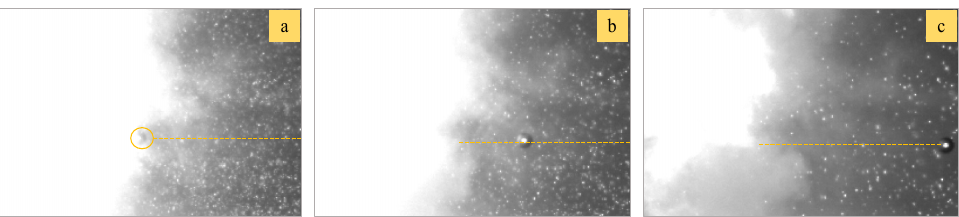
Figure 4. Typical flight trajectory of a 7 mm diameter projectile attached to the front surface of a detonator after being propelled by the explosion (Video S1): ( a ) first appearance of the projectile after its passage through the opaque gas cloud, ( b ) projectile’s trajectory after detonation, ( c ) the projectile maintains a straight flight trajectory till impact on the